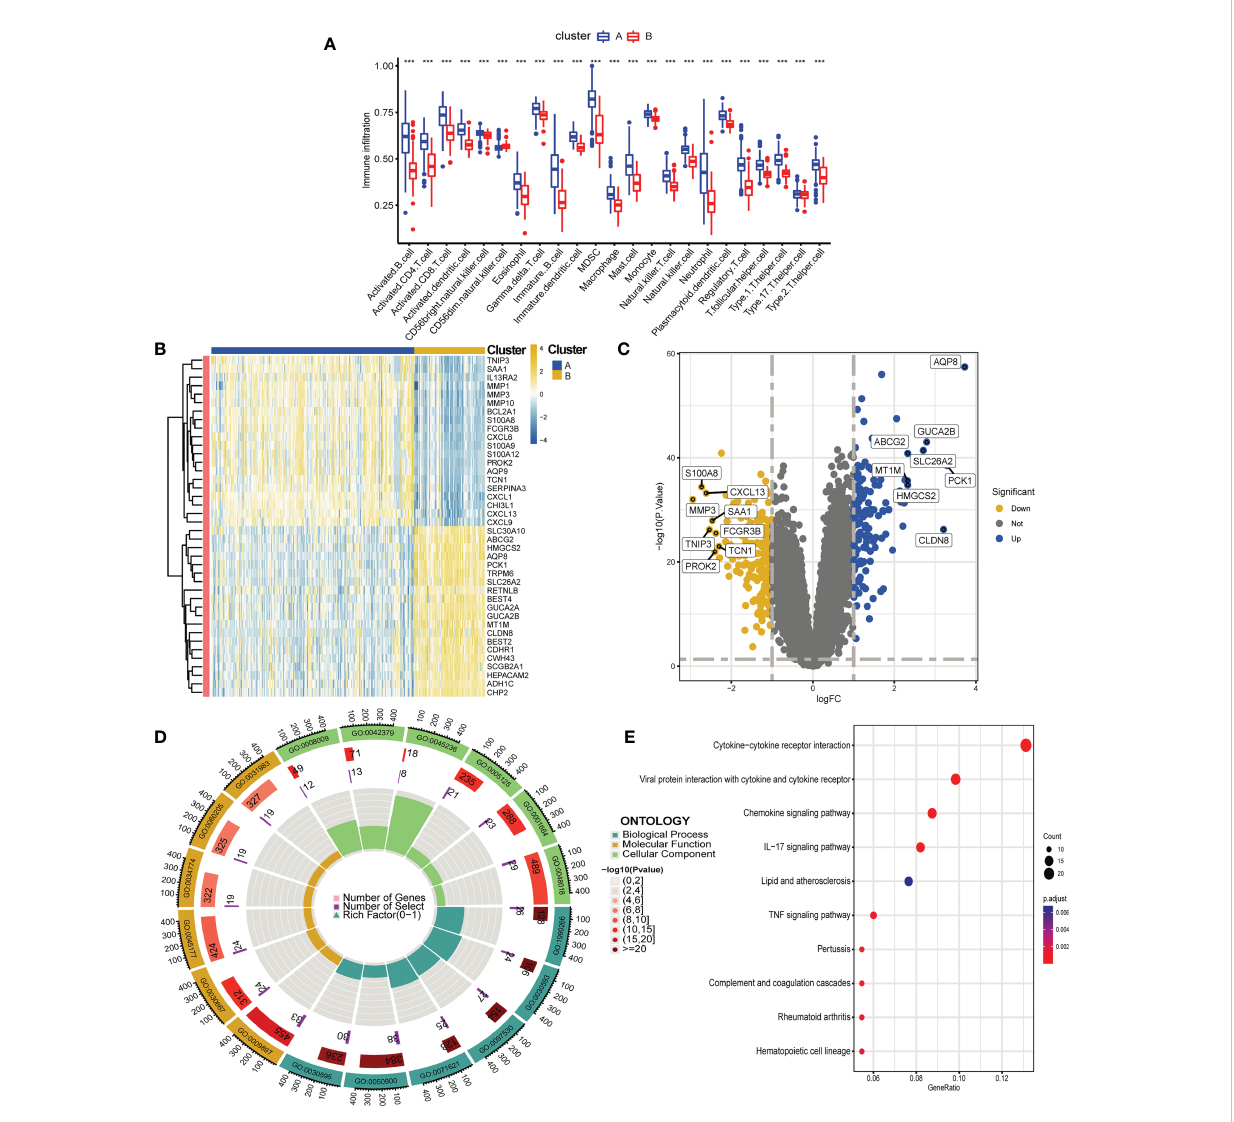
FIGURE 10 Differential analysis, functional enrichment analysis and immune in fi ltration analysis between two cuproptosis subtypes of UC, functional enrichment analysis and immune in fi ltration analysis. (A) Boxplot showing differences in immune in fi ltration between the two cuproptosis subtypes. (B, C) . Heatmap (B) and volcano plot (C) depicting DEGs between the two cuproptosis subtypes. (B) Each row of the heat map represents one DEG, and each column represents a UC sample, either the A subtype or B subtype. (C) Blue plot points represent upregulated DEGs, gray plot points represent genes with no signi fi cant difference, and yellow plot points show downregulated DEGs. (D, E) . GO (D) and KEGG (E) enrichment analyses of DEGs between the two cuproptosis subtypes. ***p <